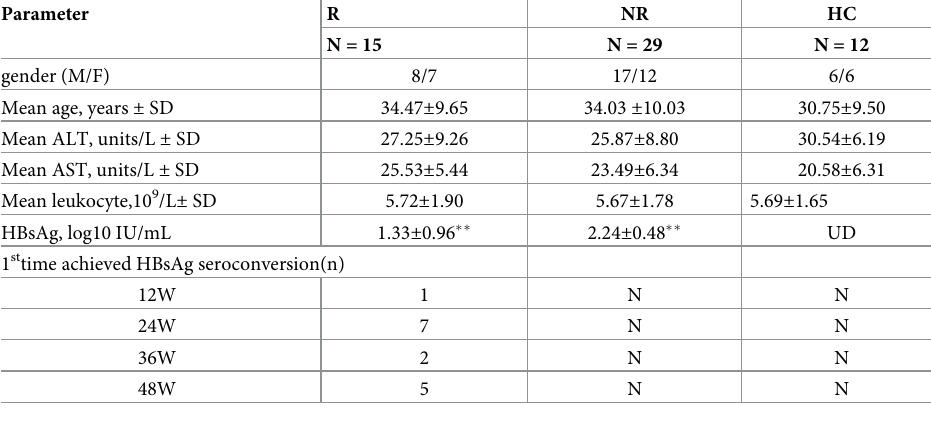
Table 1. Patients’ demographic and clinical data.